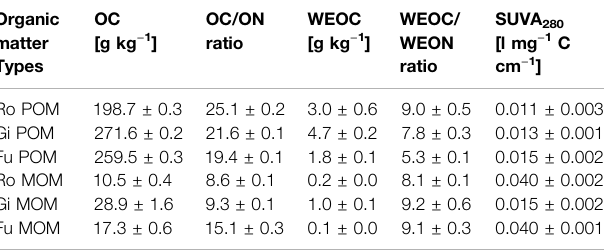
TABLE 3 | Content of organic carbon (OC) and water-extractable OC (WEOC) as well as the OC/ON and WEOC/WEON ratios of particulate and mineral- associated organic matter (POM, MOM) fractions used for incubation